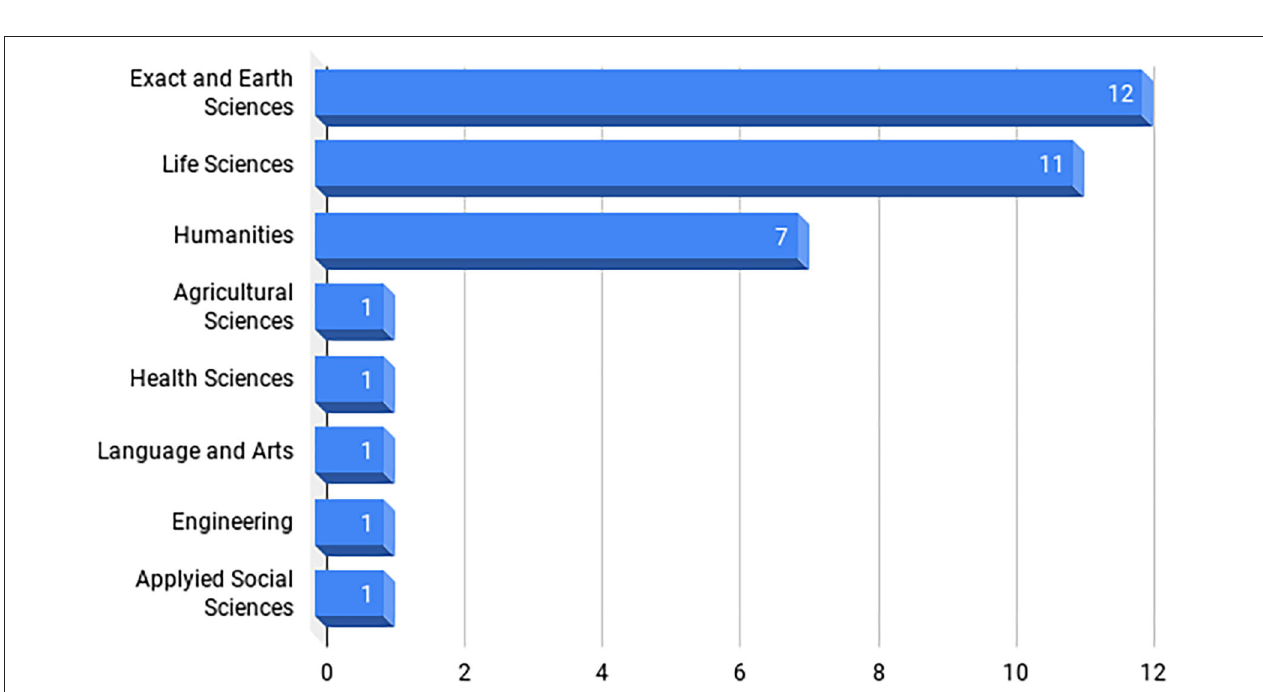
FIGURE 4 | Areas of education and expertise of science Youtubers.